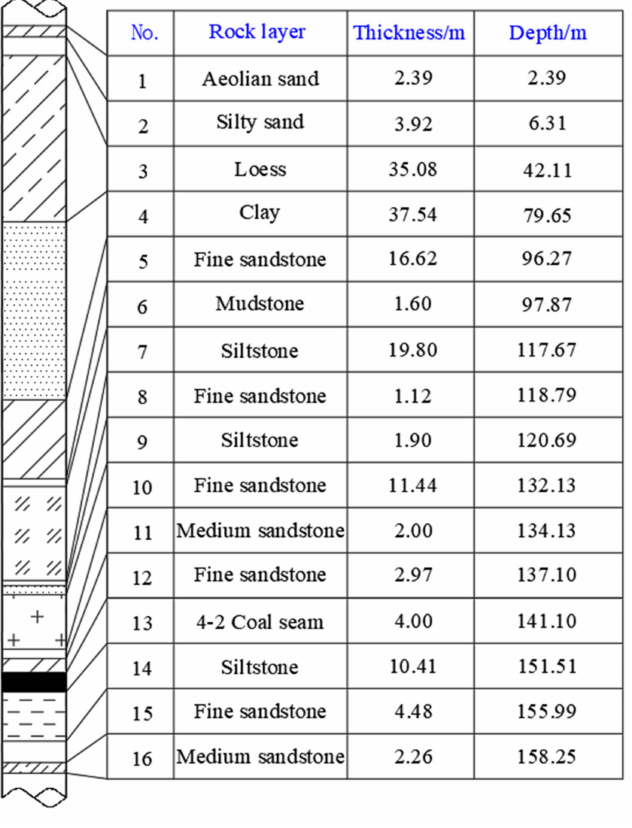
Figure 2. A borehole histogram is displayed in the L7